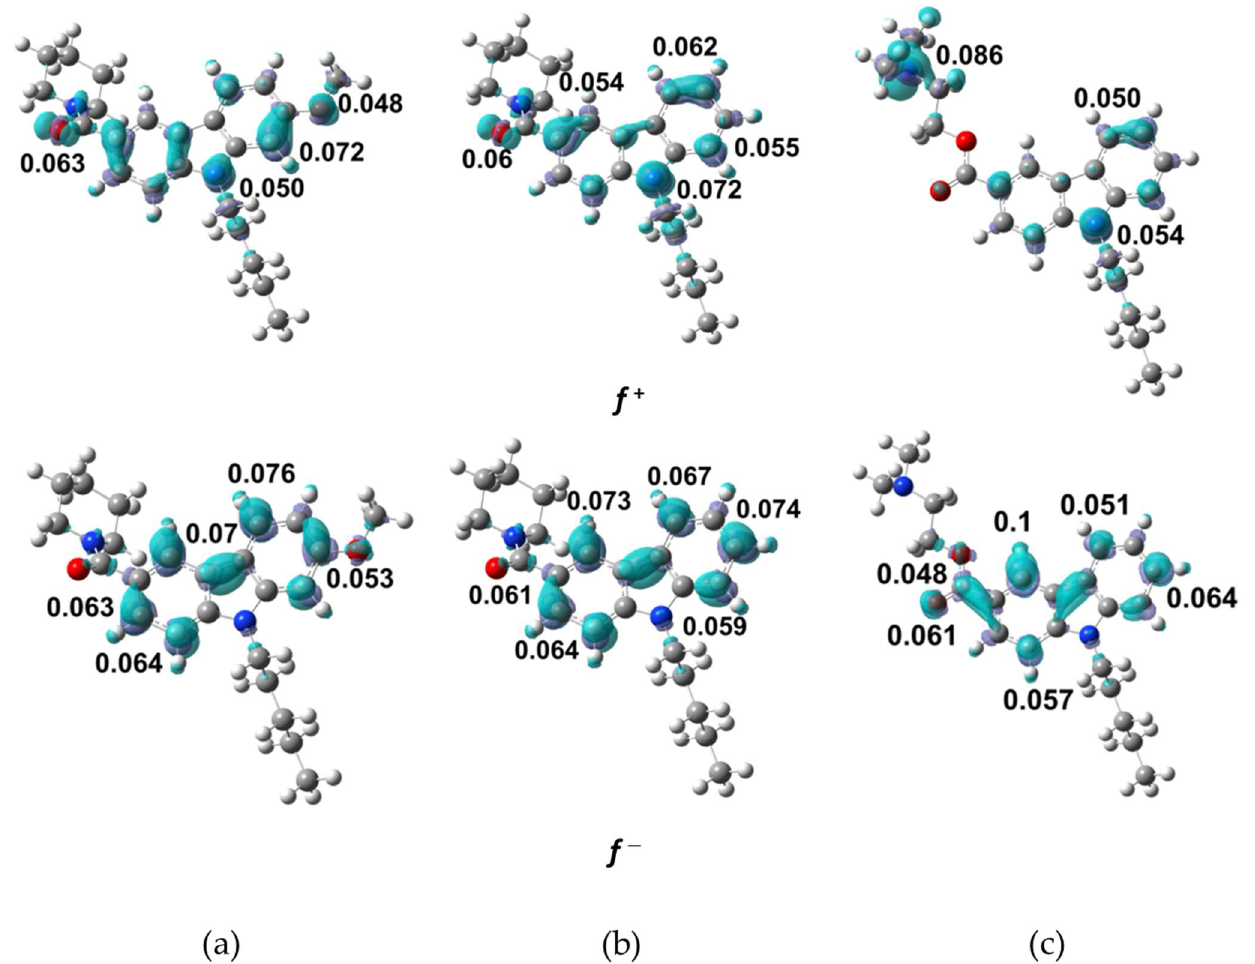
Figure 6. Fukui functions, f + ( r ) and f − ( r ) . In: ( a ) NMP-4, ( b ) NMP-7, and ( c ) NMP-181 compounds at BP86/cc-pVTZ level of theory in chloroform.